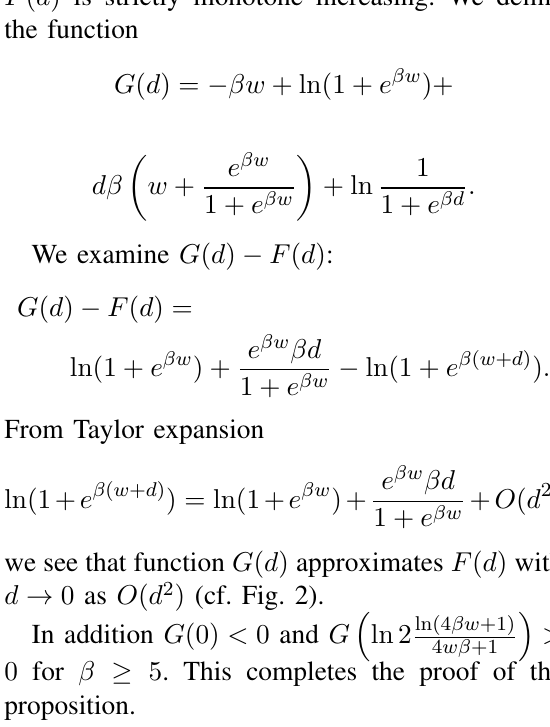
for β = 10 , w = 4 ; d ≤ δ,δ